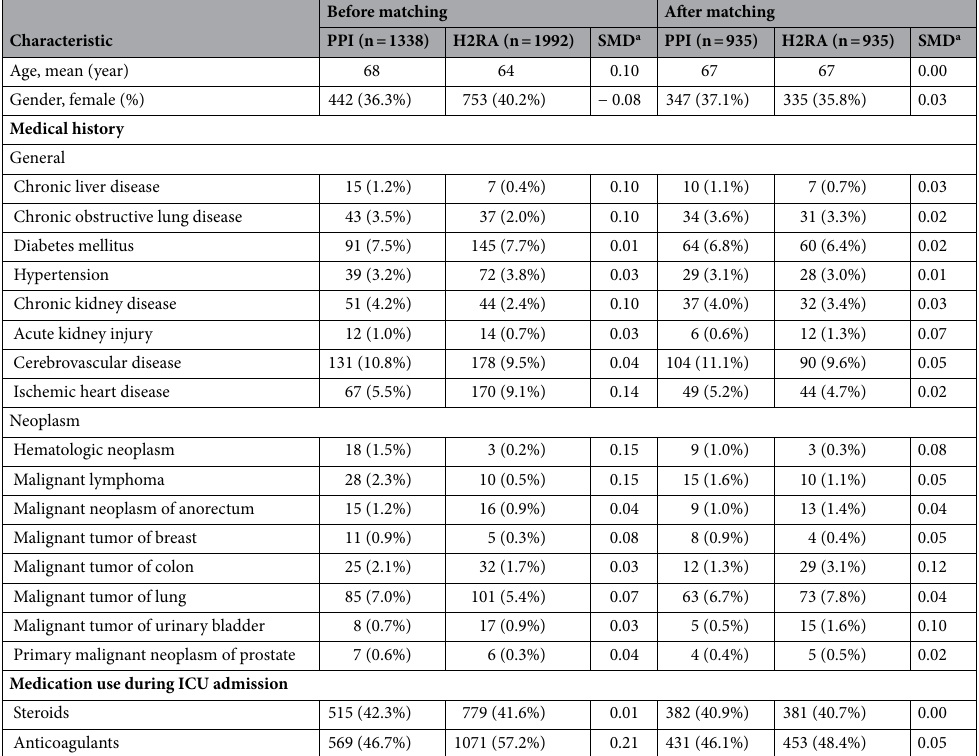
Table 1. Baseline characteristics of the study population before and after propensity score matching. H2RA histamine-2 receptor antagonist, PPI proton pump inhibitor, SMD standardized mean difference. a Standardized mean difference less than 0.1 indicates good balance of the characteristics after propensity score matching.